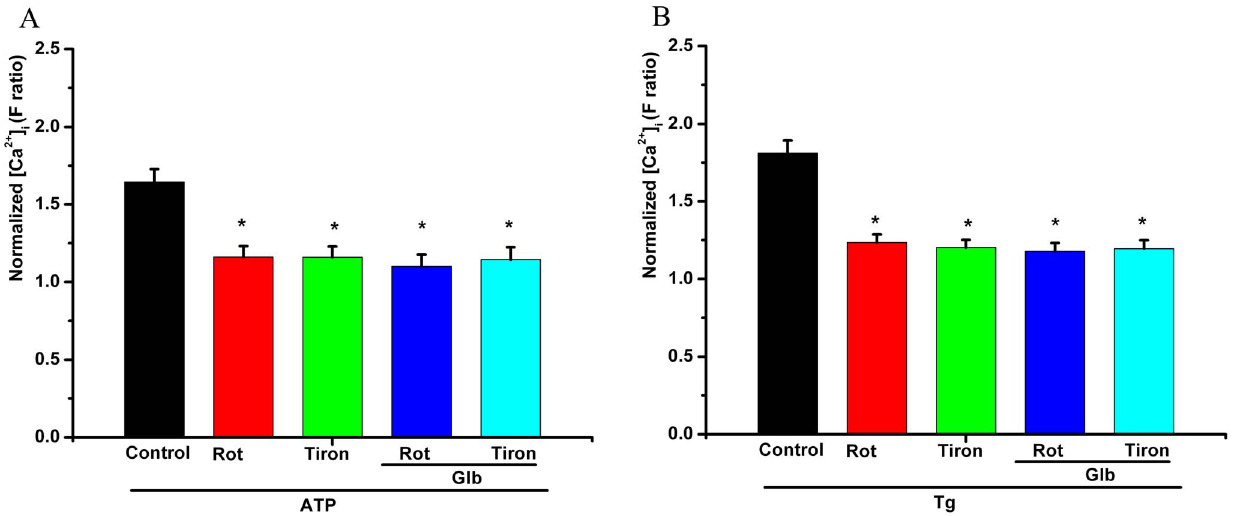
Figure 7. The role of intracellular ROS and mitochondrial activity in the effect of glibenclamide on ATP-induced [Ca 2 + ] i transient elevation. When pretreated with tiron and rotenone, glibenclamide could not further decrease the maximal ATP- or Tg-induced [Ca 2 + ] i .